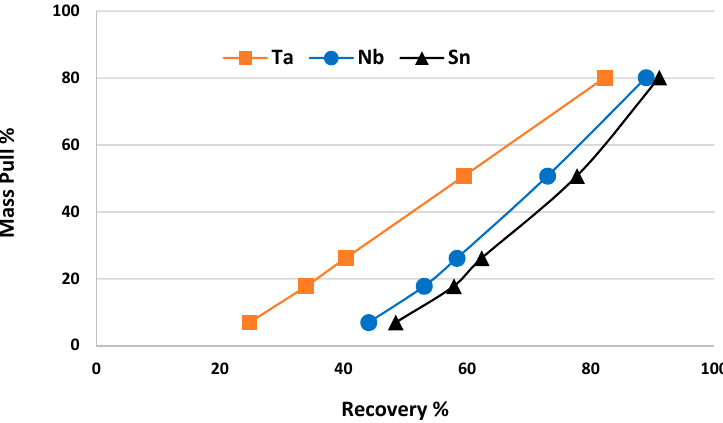
Figure 9. Mass pull (%) and recovery (%) for Wilfley shaking table rougher test on Penouta sample, measured using PXRF.